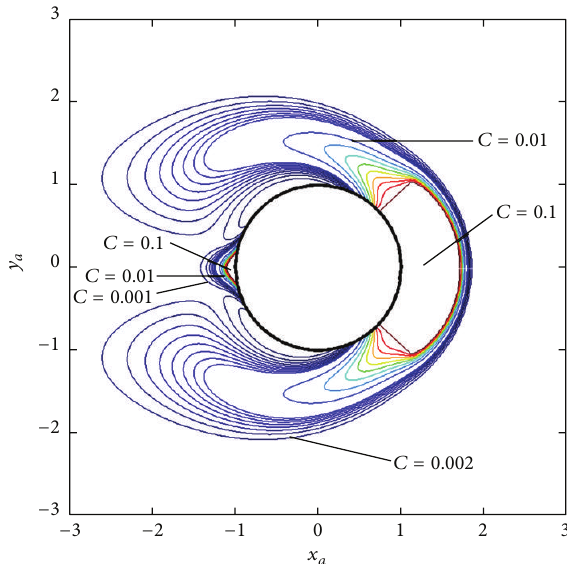
Figure 5: The concentration contours of Mn 2 P 2 O 7 ⋅ 3H 2 O nanopar- ticles of 24 nm diameter at 𝑡 = 10.24 s.